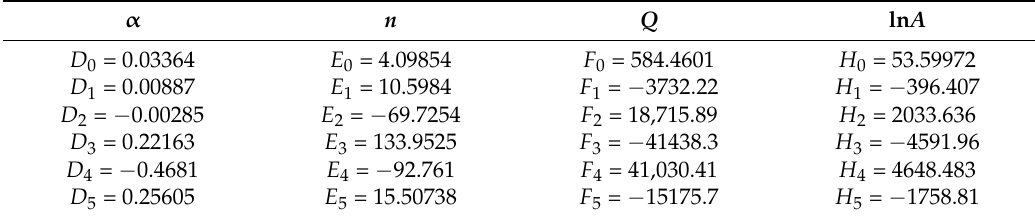
Table 4. Polynomial coefficients for α , n , Q , ln A for 950–1050 ◦